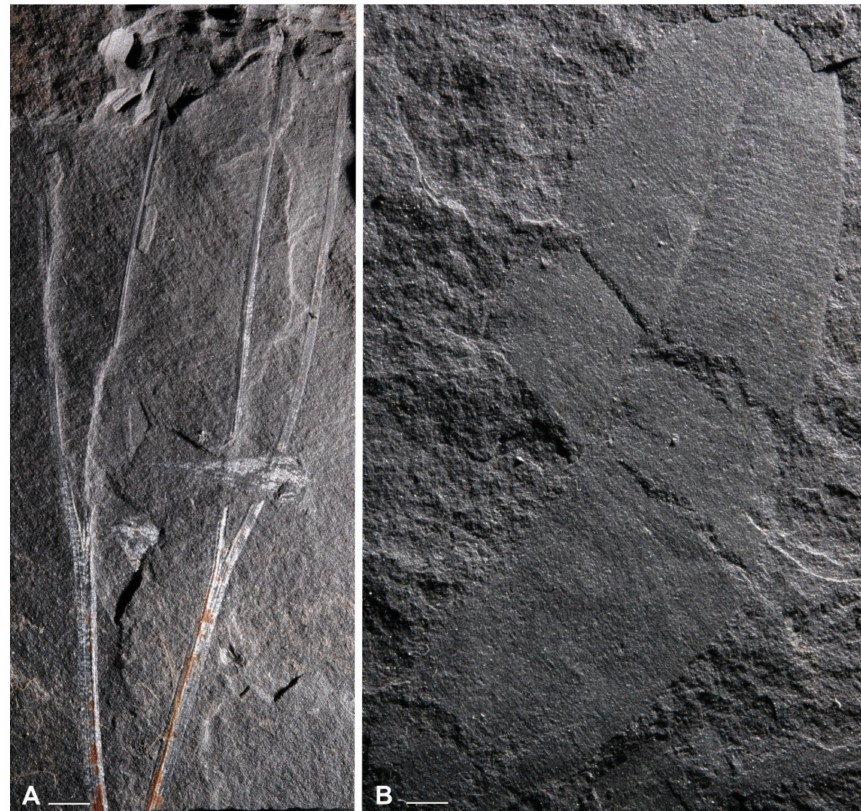
Figure 17. Plant remains from the La Mure Basin, SE France: ( A )— Dicranophyllum sp. isolated bifurcating single-veined leaf, the vein is accompanied by lateral stomata furrows, MHNGr PA.39970; ( B )— Lesleya sp. isolated leaf, MHNGr PA.39971; scale bars: 5 mm; photo: D.